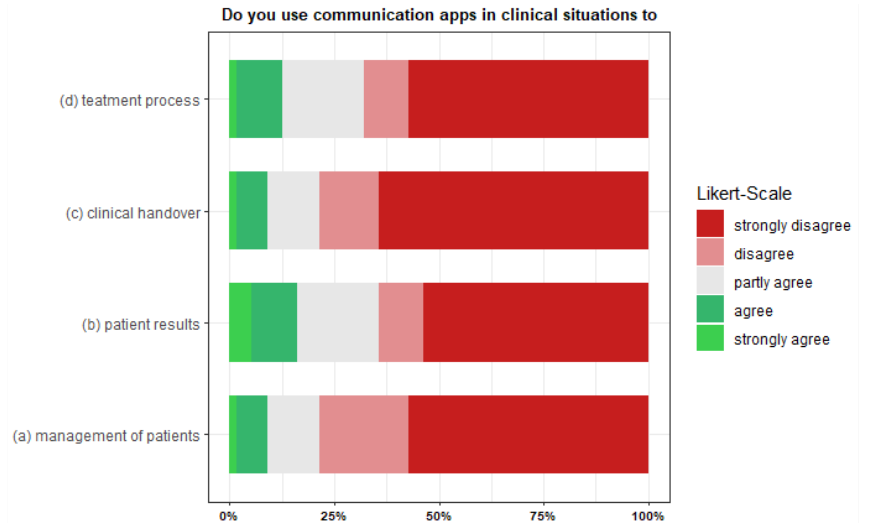
Figure 2. “ Do you use communication apps in clinical situations to ( a ) communicate with colleagues ( b ) update colleagues about patient results? ( c ) facilitate clinical handover? ( d ) inform colleagues about the treatment process?” ( N = 70).